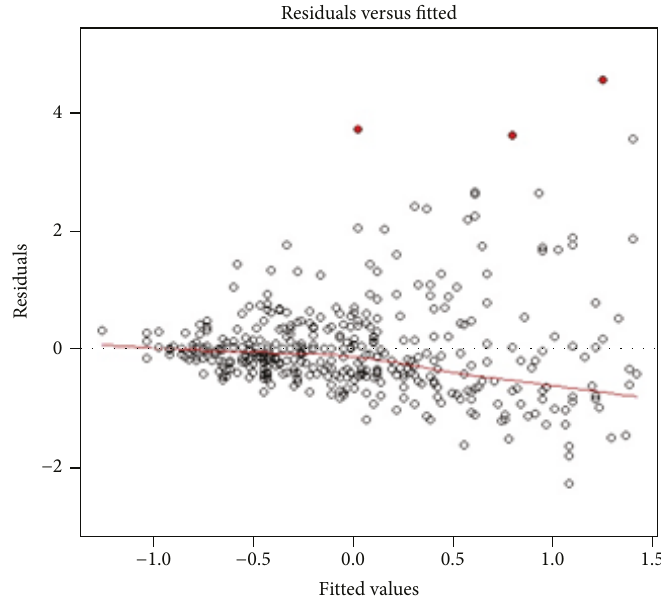
Figure 3: Graph of dependencies between the regression model for the original data set from [32] and residual values with three outliers